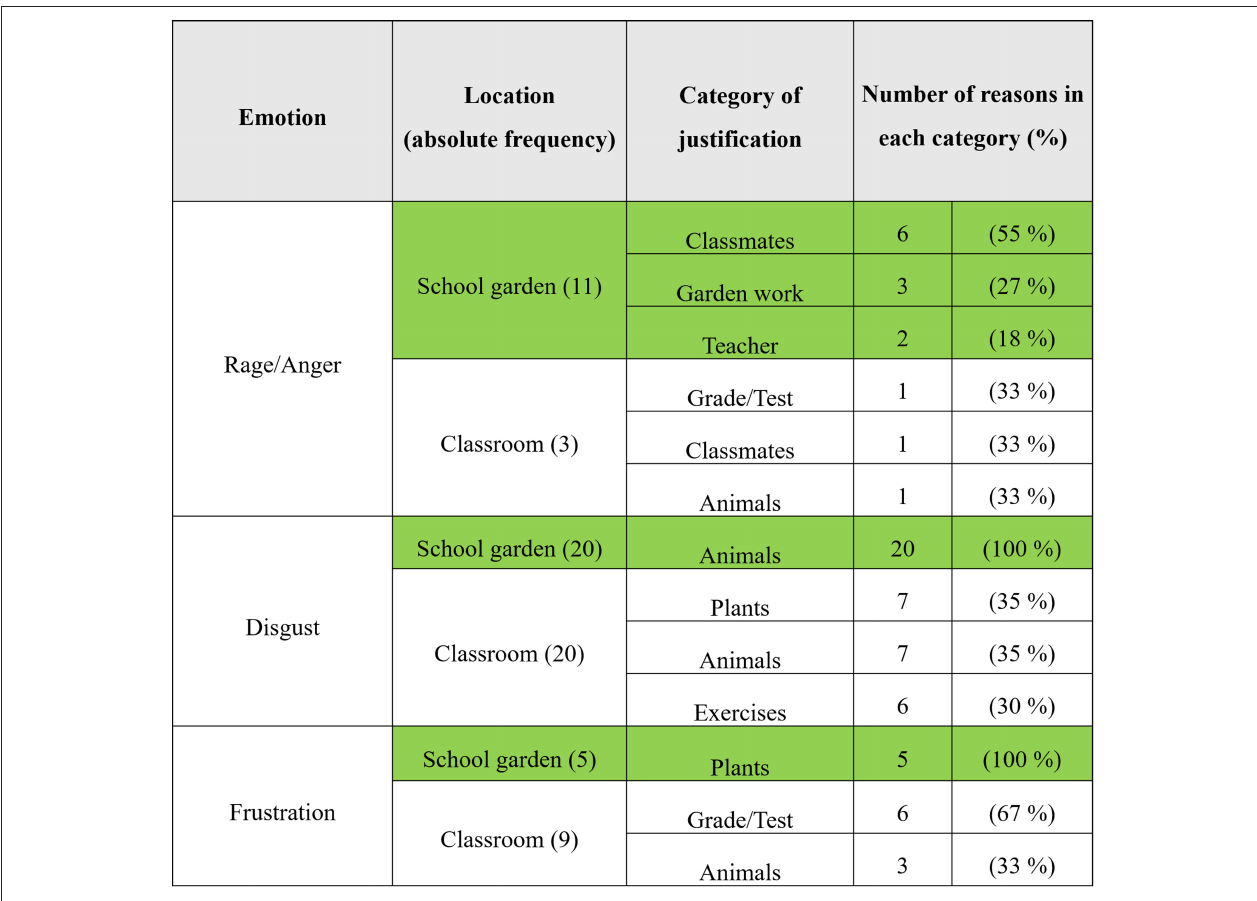
FIGURE 7 | Reasons of negative emotions (school garden n = 223; classroom n = 215).